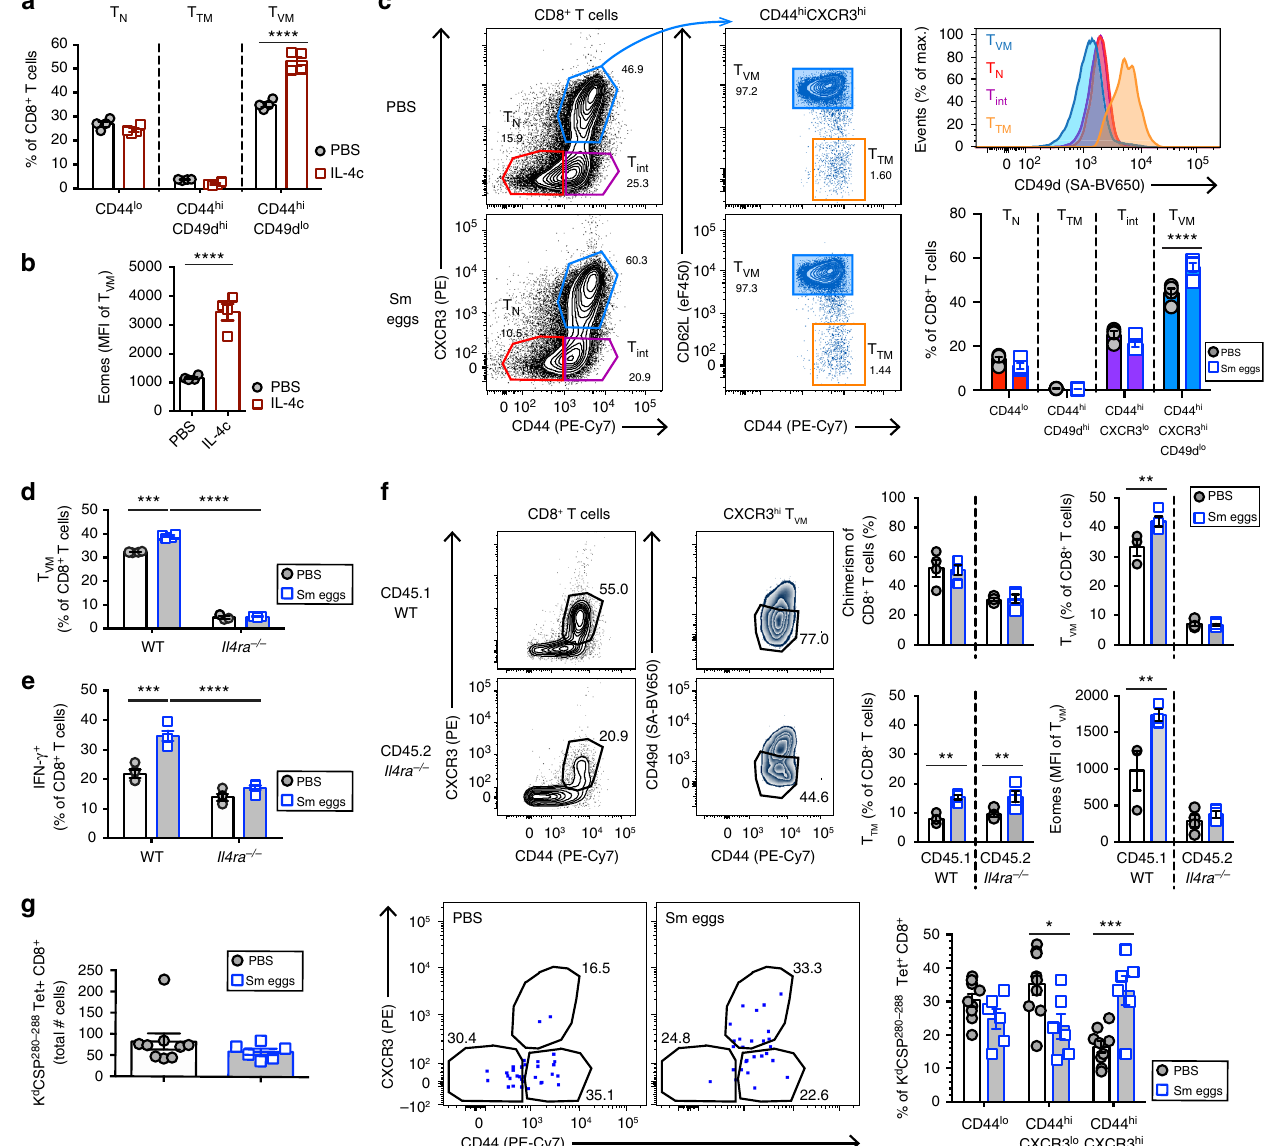
Fig. 2 IL-4 signaling in CD8 + T cells expands T VM after S. mansoni egg immunization. a IL-4c treatment in BALB/c mice at d0 and d2 before analysis at d4.